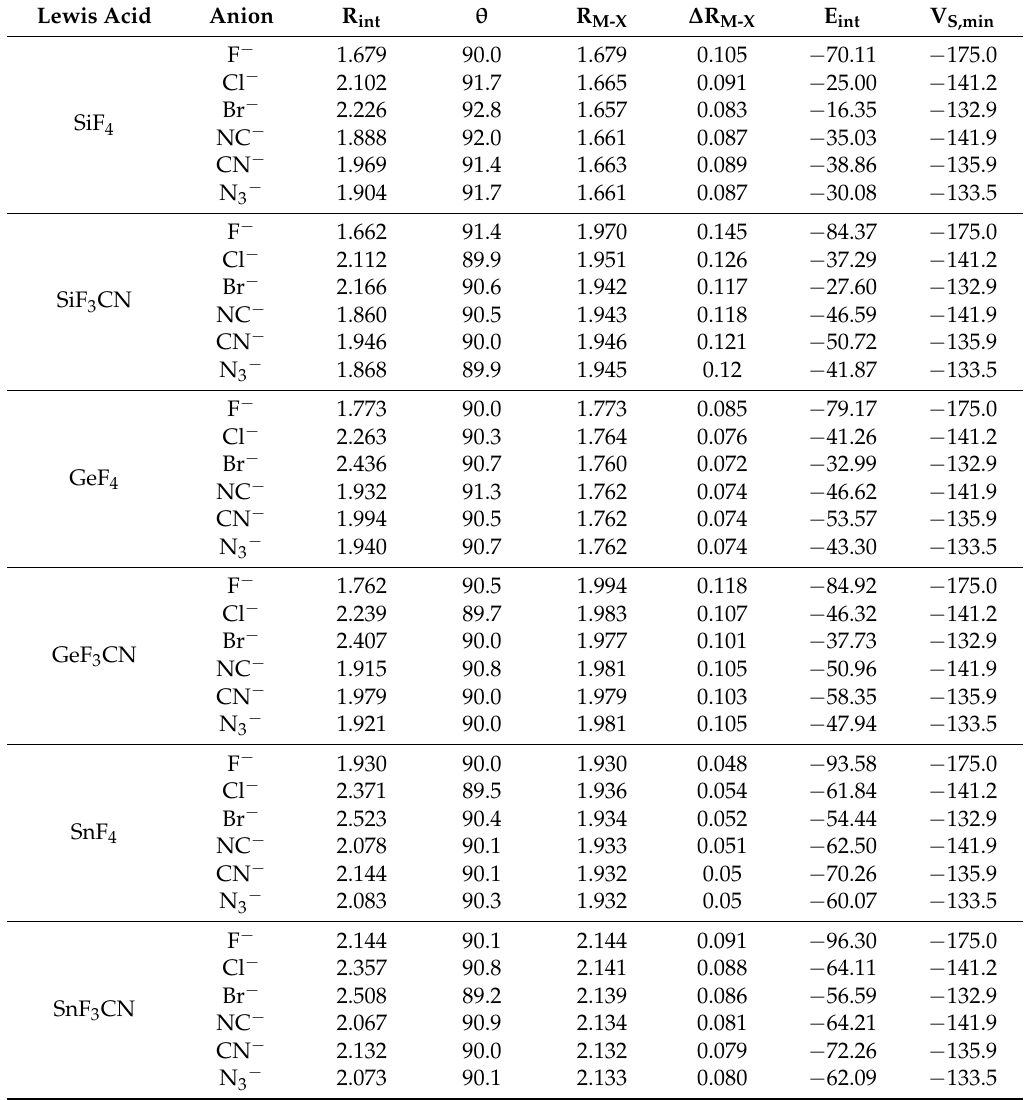
Table 1. Binding distances (R int , Å), X-M-F angles ( θ , ◦ ), M-X bond lengths (R M-X , Å) and their changes with respect to those of isolated MF 3 X monomers ( ∆ R M-X , Å), interaction energies (E int , kcal/mol) of the anionic tetrel-bonded complexes, and the calculated local MEP minimum values (V S,min , kcal/mol) of the